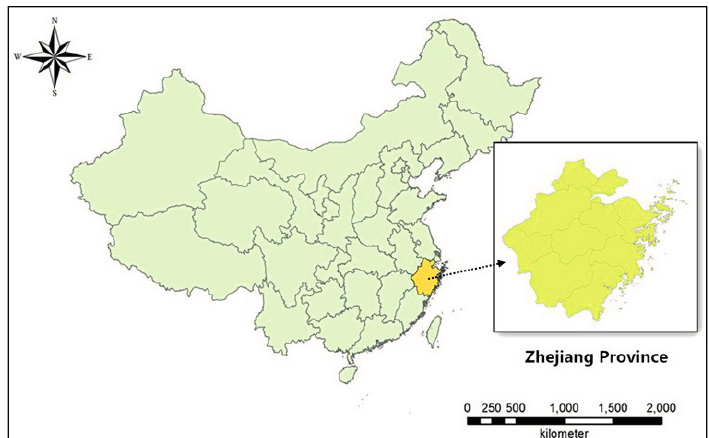
Figure 3. The location of Zhejiang in